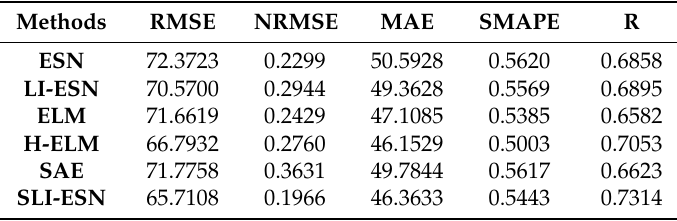
Figure 8. PM 2.5 concentration ten-step (10 hours) prediction curve. Table 4. Comparison of ten-step (10 hours) prediction Table 5. Comparison of running time on six methods (second).